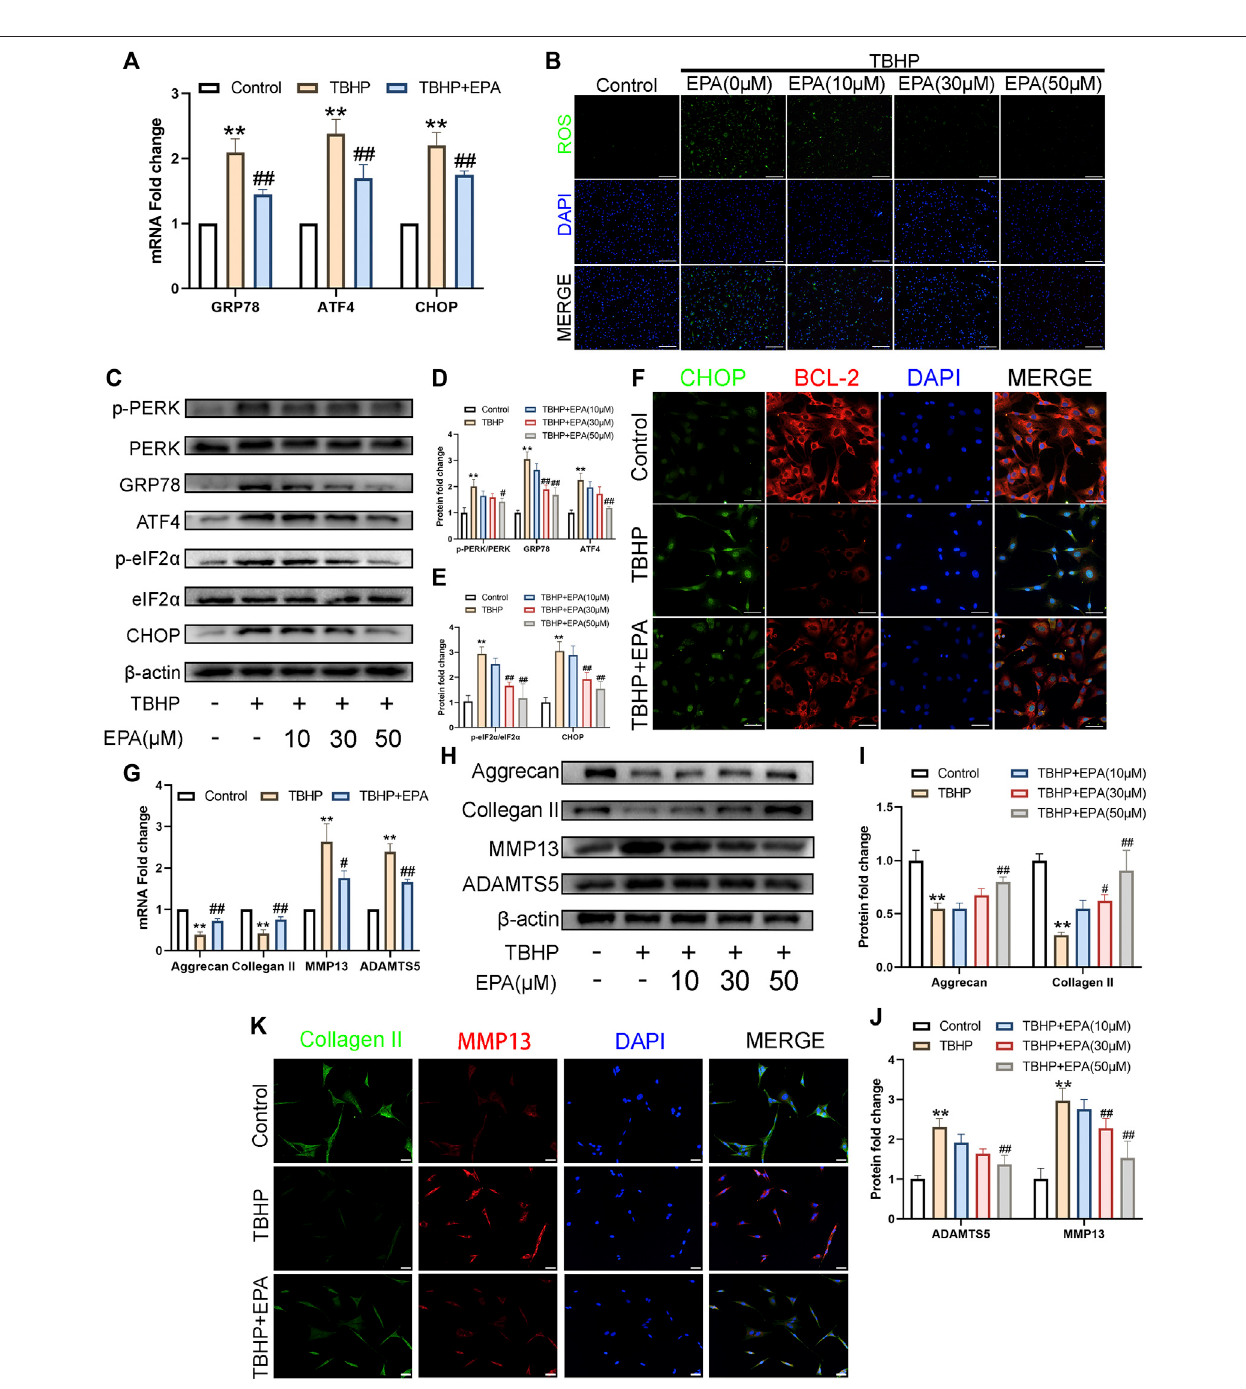
FIGURE 3 | EPA inhibits apoptosis by alleviating ER-stress, while maintaining ECM anabolism and catabolism in NPCs. (A) The gene expression of ER stress relatedbiomarkerprotein, suchasGRP78,ATF4,andCHOPweredetectedbyqPCRintheNPCs, treatedwithorwithouttheadministrationofEPAwithTBHPfor24 h. (B) Reactive Oxygen Species (ROS) in NPCs were assessed with ROS Assay Kit (green). Nuclei were counterstained with DAPI (blue) (bar: 100 μ m). (C – E) The protein expression of p-PERK/PERK, GRP78, ATF4, p-eIF2 α /eIF2 α and CHOP were detected by western blot in the NPCs. (F) Immuno fl uorescence staining of CHOP (green) and BCL-2 (red), and quantitation of the number of chondrocytes positive for CHOP and BCL-2 in different groups. Nuclei were counterstained with DAPI (blue) (bar:20 μ m). (G) ThegeneexpressionofAggrecan,CollagenII,MMP13andADAMTS5weredetectedbyqPCRintheNPCs,treatedwithorwithouttheadministrationof EPA with TBHP for 24 h. (H – J) The protein expression of Aggrecan, Collagen II, MMP13, and ADAMTS5 were detected by western blot in the NPCs. (K) Immuno fl uorescence staining of Collagen II (green) and MMP13 (red). Nuclei were counterstained with DAPI (blue) (bar: 20 μ m). The values presented are the means ± SD ( n (cid:2) 3). * p < 0.05, ** p < 0.01, compared with the control group; # p < 0.05, ## p < 0.01, compared with the TBHP treatment group.